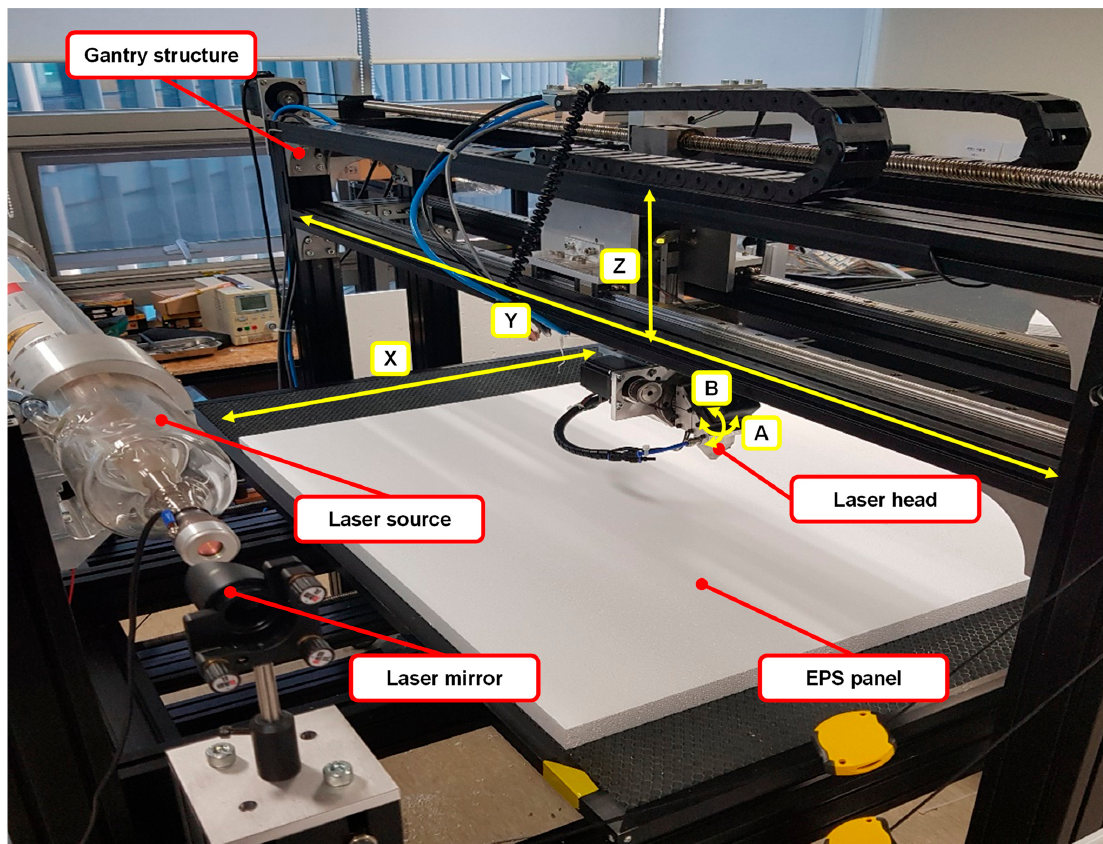
Figure 4. Laser based cutting machine of EPS panel.